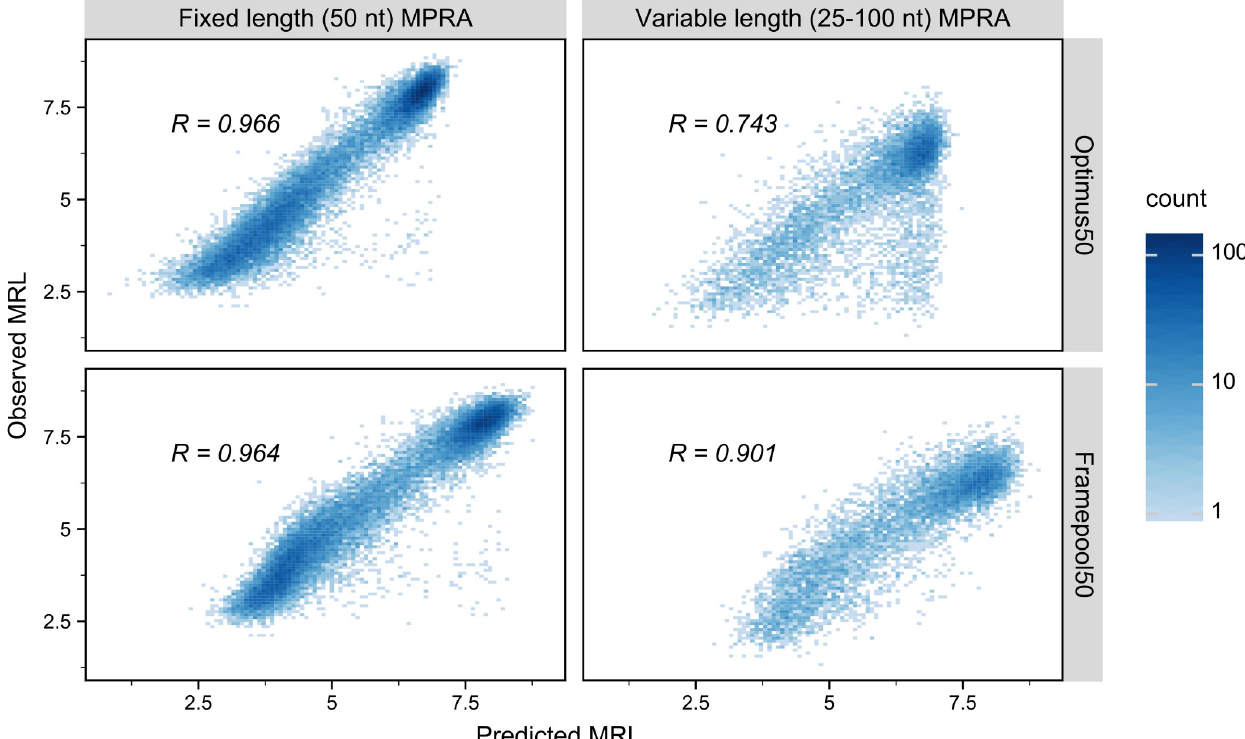
Fig 2. Performance of Optimus50 and FramePool50 on MPRA test-sets. Observed Mean ribosome load (MRL, y-axis) against predicted MRL (x-axis) for Optimus50 (top row) and FramePool50 (bottom row) on the 50 nt fixed-length MPRA dataset (left column) and the variable-length MPRA dataset (right column). Optimus50 performs very well when evaluated on a test set of 20,000 random 50 nt long 5’UTR sequences. However, its performance drops strongly when evaluated on a test set of 7,600 random 5’UTR sequences which vary in length from 25 to 100 nt. This is because sequences longer than 50 nt need to be truncated to fit the model. Despite not having position-specific weights, the frame pooling model captures almost as much signal as Optimus on the short MPRA sequences. Additionally, it generalizes very well to the variable-length MPRA data, strongly outperforming Optimus50. This shows the ability of the frame pooling approach to capture predictive signals even in sequences considerably longer than those it has been trained on.